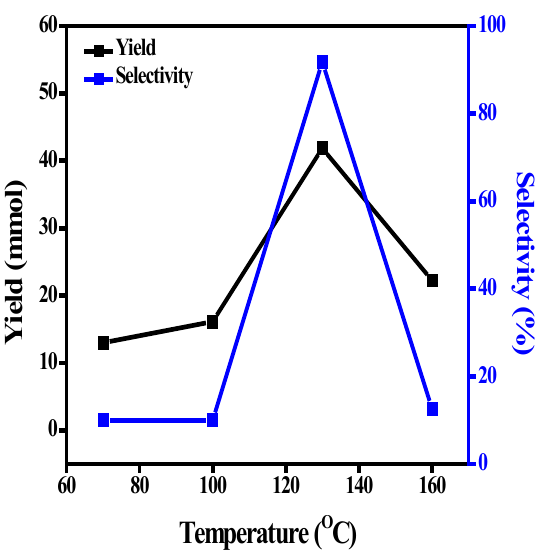
Figure 6: Effect of temperature on yield and selectivity of DMC production under reaction conditions: MeOH: 625 mmol, IL: 1.28